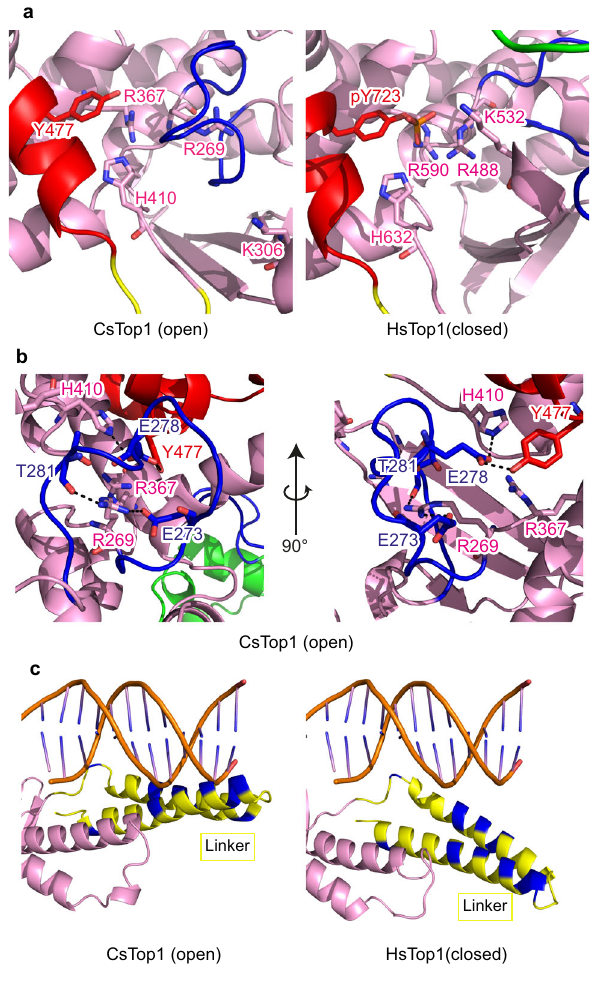
Fig. 4 DNA-binding region of TOP1 in the open and closed conformations. a Comparison of the relative positions of DNA interacting residues of CsTOP1 and HsTOP1. b Interaction between the lip2 and DNA interacting residues in the open state CsTOP1. CsTOP1 coloring is the same as in Fig. 1. c Position of the linker and DNA in the HsTOP1 crystal structure (PDB 1K4T) 10 (right panel). For the left panel, the putative position of the DNA molecule interacting with CsTop1 is calculated after superposition using Pymol of CsTop1 structure with HsTOP1-DNA structure (PDB 1K4T). The basic residues are colored